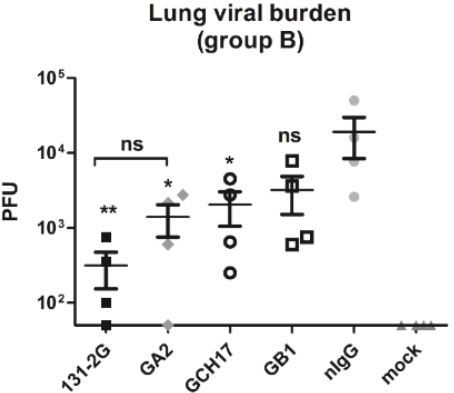
Figure 7. Lung virus titers following RSV challenge of mice passively transferred with purified IgG from mice vaccinated with LbL nanoparticles. Mice were challenged i.n. with 10 6 PFU RSV A2, and passively transferred with purified IgG from group A (Study 2) on day 2 and 4 post challenge. At day 5 post challenge lung virus titers were determined by immunostaining plaque assay. Data are presented as total PFU/whole lung tissue. Values shown as the mean ± SEM (one-way ANOVA); ns, non-significant; * p < 0.05; ** p < 0.005 vs . nIgG group.